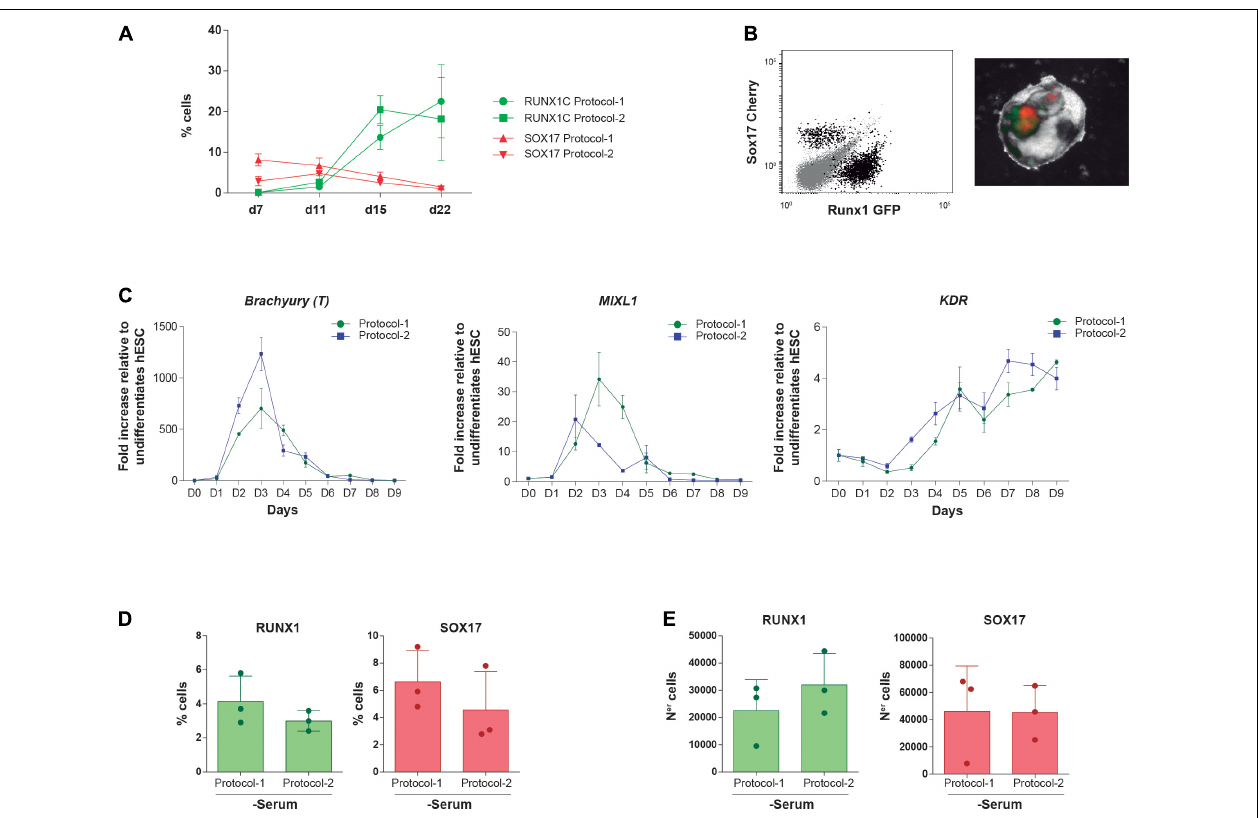
FIGURE 2 | Impact of both differentiation protocols on the emergence kinetics of SOX17 + HE and RUNX1C + definitive hematopoietic cells. (A) Frequency of alive (7AAD–) SOX17 :Cherry + and RUNX1C:GFP + cells along EB differentiation with protocol 1 and protocol 2 ( n = 4). (B) Left panel , representative flow cytometry plots displaying how (SOX17/Cherry +) and definitive hematopoietic cells (RUNX1/GFP +) are identified. The right panel shows mCherry and GFP expression within differentiating EBs by fluorescence microscopy. (C) Gene expression kinetics of the mesendodermal transcription factors Brachyury (T), MIXL1, and KDR during mesoderm induction and early hematopoietic differentiation with protocol 1 and protocol 2 ( n = 4). (D,E) Frequency (D) and absolute numbers (E) of RUNX1/GFP + definitive hematopoietic cells and SOX17/Cherry + HE cells at endpoint (day 22) of in vitro differentiation using protocol 1 or protocol 2 in a serum-free media. Data were plotted as mean ± SD. n.s., not